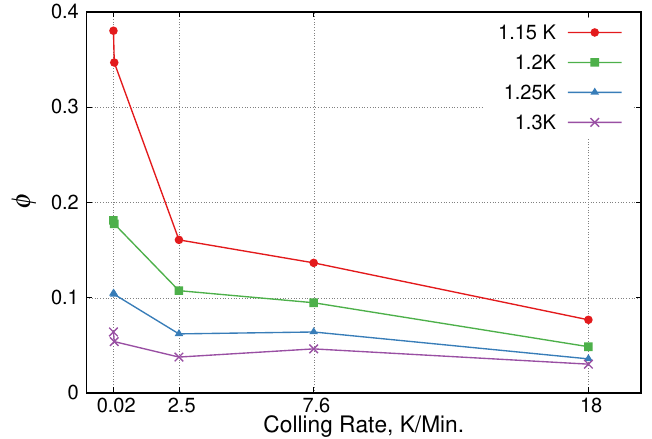
Figure 4. Dependence of SC volume ratio φ on cooling rate calculated using Equation (10) for different temperatures. For this calculation, the experimental data from the inset of Figure 1d in Ref. [7] are